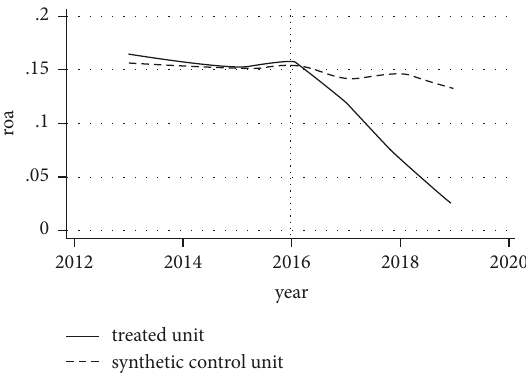
Figure 1: ROA figure of Gaozheng explosive. Note: Gaozheng explosive was listed through the “IPO green channel” for poverty alleviation in 2016, and the development trends of the treatment group and control groups were basically the same before the IPO policy for poverty alleviation was proposed in 2016, and there was a change by the time the policy occurred in 2016, with a sharp decline trend in the treatment group fold and a flattening trend in the control group fold. There is a large difference between the two (the figure is directly exported by Stata